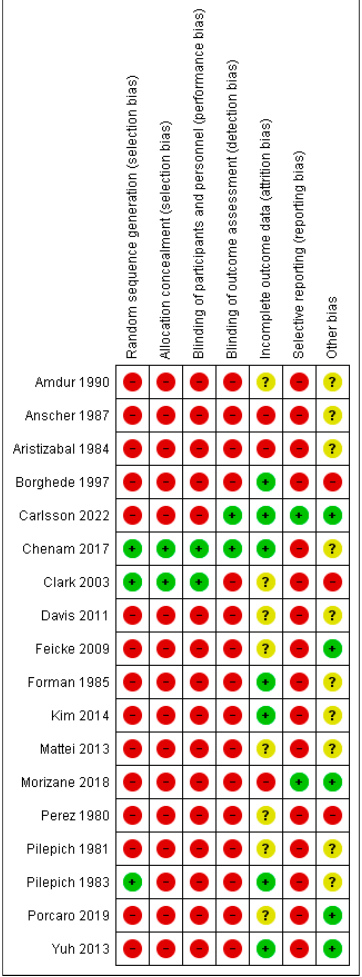
Figure 2. Risk of bias summary representing the author’s judgement about each risk of bias topic for each included study.